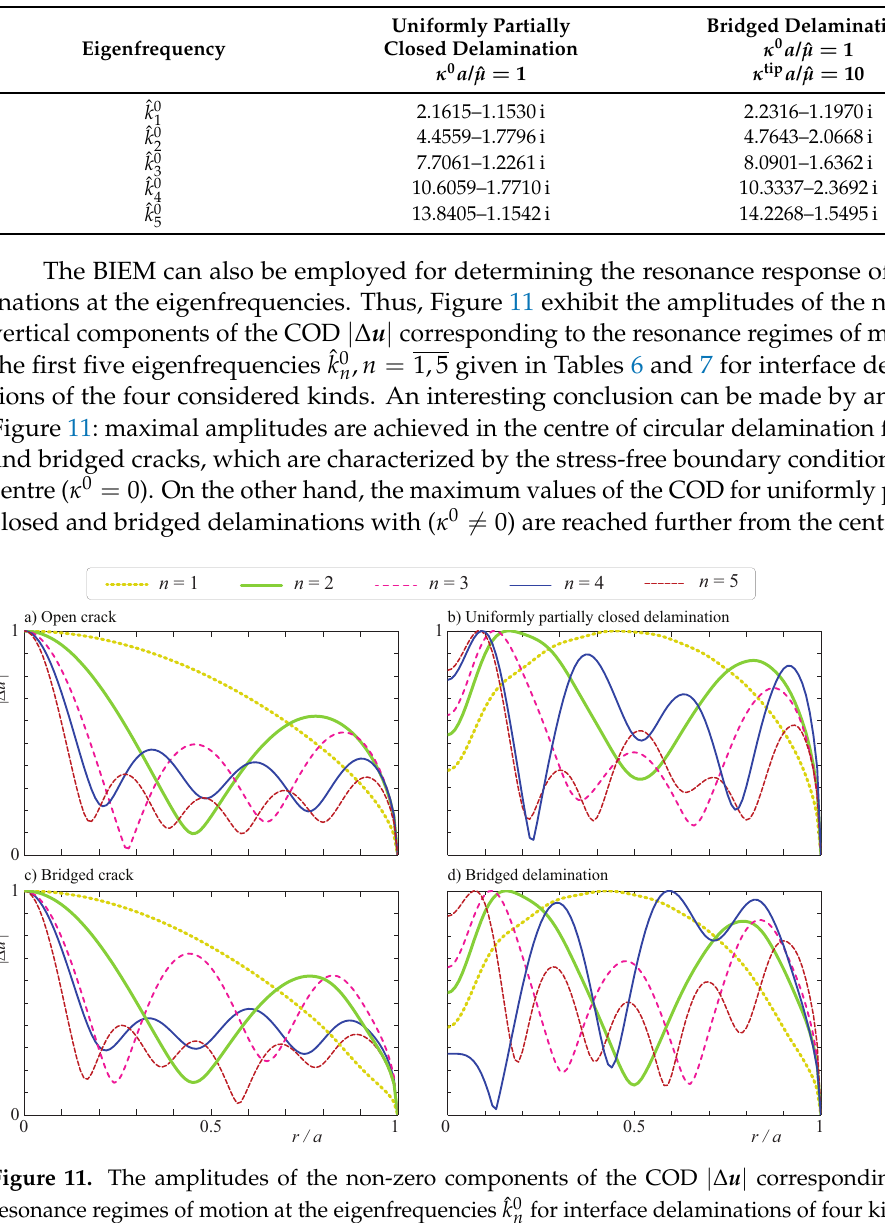
Table 7. Eigenfrequencies ˆ k 0 n for uniformly distributed and bridged delaminations between alu- minium and polycarbonate.